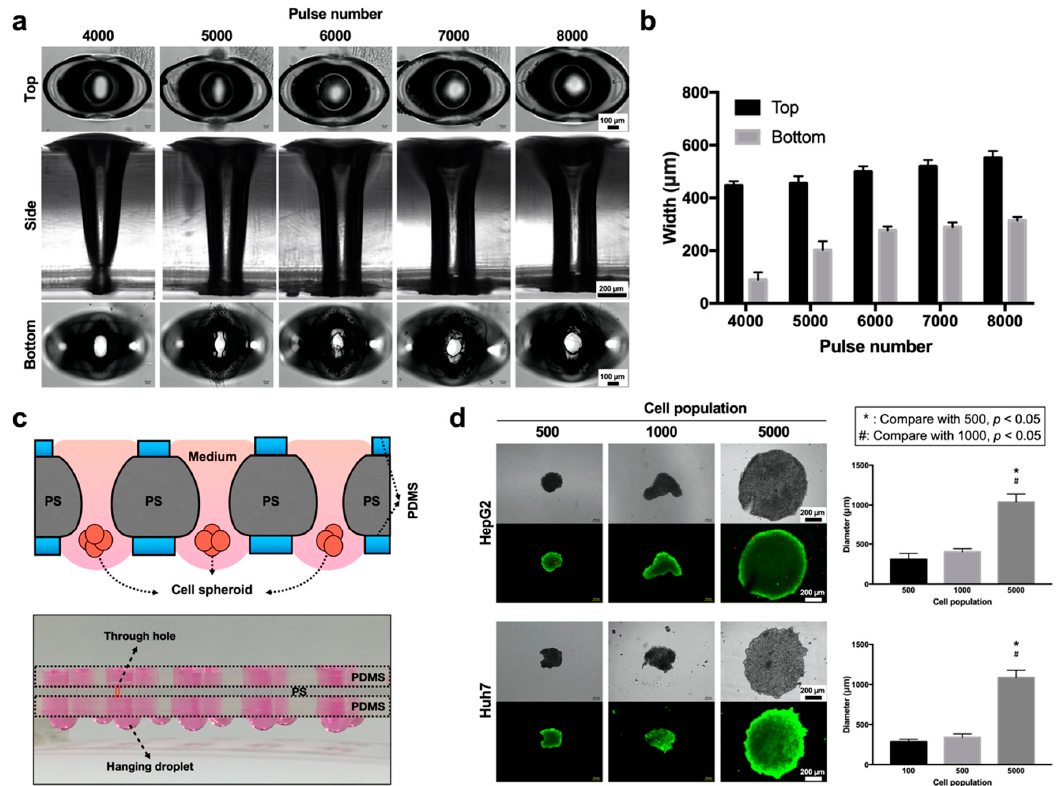
Figure 5. Characterizations of PS through-hole structures for the formation of Huh7 and HepG2 MCTSs. ( a ) Images of through-hole ablation at various angles (top, cross section, bottom). ( b ) Evaluation of the top and bottom widths of both sides of the through-hole structure at different pulse numbers. ( c ) Illustration of the designed 10 hanging drop spheroid culture array device (top) and its cross-sectional view (bottom). ( d ) Bright-field (gray) and fluorescence images of live (green) /dead (red) stained HepG2 and Huh7 cell spheroids (5000 cell populations) generated with various starting cell populations over a 4-day culture period (left). Average diameters of HepG2 and Huh7 spheroids over the 4 days of culture using various initial cell numbers per spheroid (right).